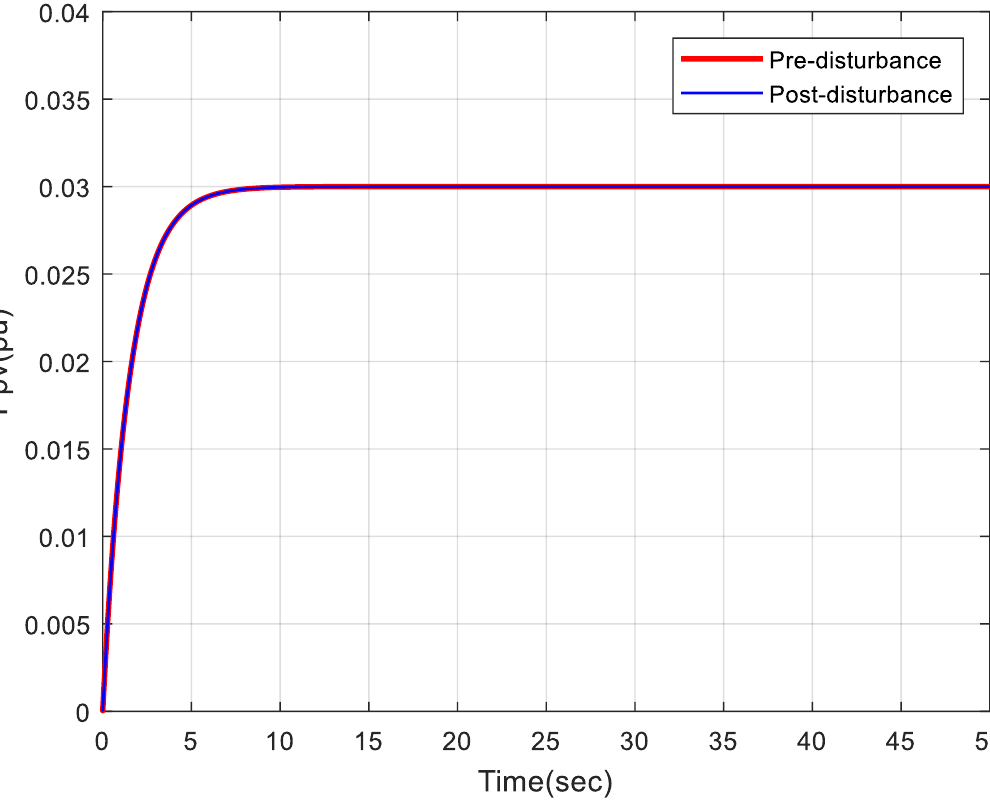
Figure 12. Battery power (pre- and post-disturbance).